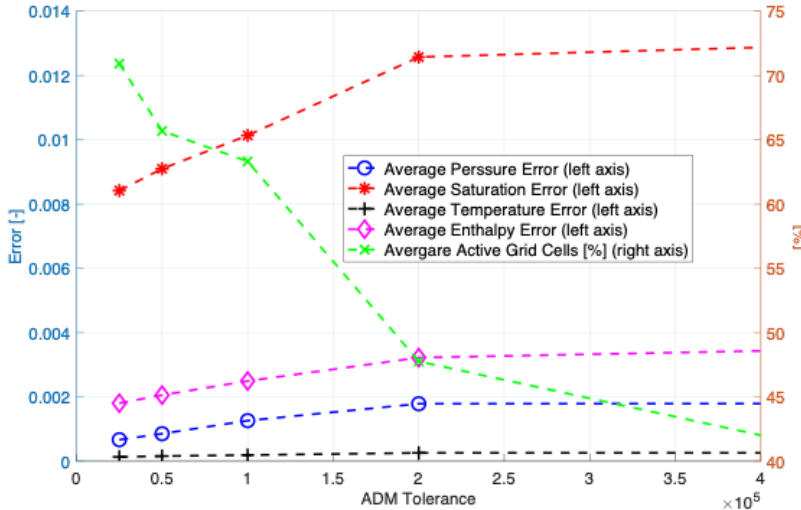
Figure 9. ADM errors and the percentage of the active cells used for each ADM run. The error for each parameter as well as the percentage of the active cells for each ADM run are averaged over the entire simulation.